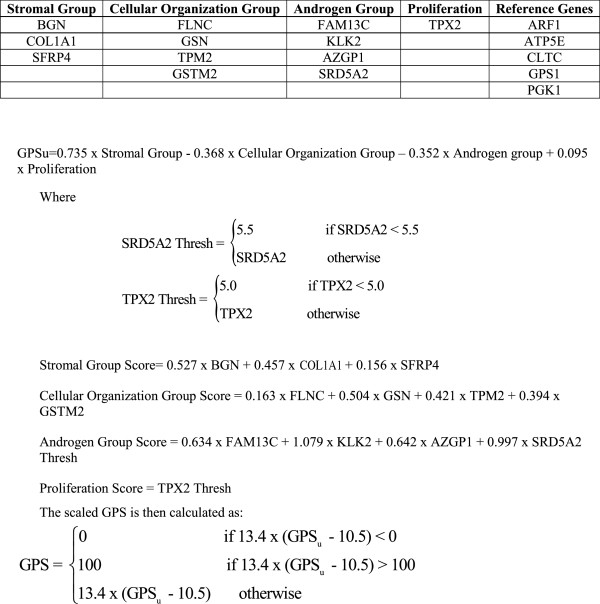
Calculation of Genomic Prostate Score (GPS). The aggregate expression of 5 reference genes was used to reference normalize the expression of the 12 cancer-related genes. Normalized gene expression was used to calculate the individual group scores: stromal group score, cellular organization score, androgen groups score and proliferation score. Each of those group scores is algorithmically combined to calculate the unscaled Genomic Prostate Score (GPSu); the GPSu is then scaled to a 100-unit range GPS. A negative coefficient in the calculation of the GPS is associated with better outcome whereas a positive coefficient is associated with poorer outcome.